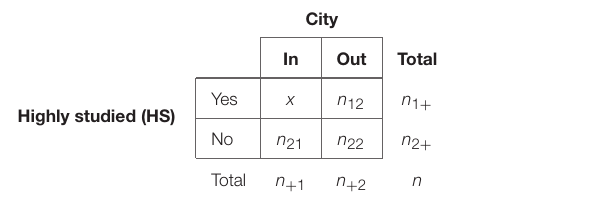
TABLE 2 | Contingency table for the enrichment analysis.